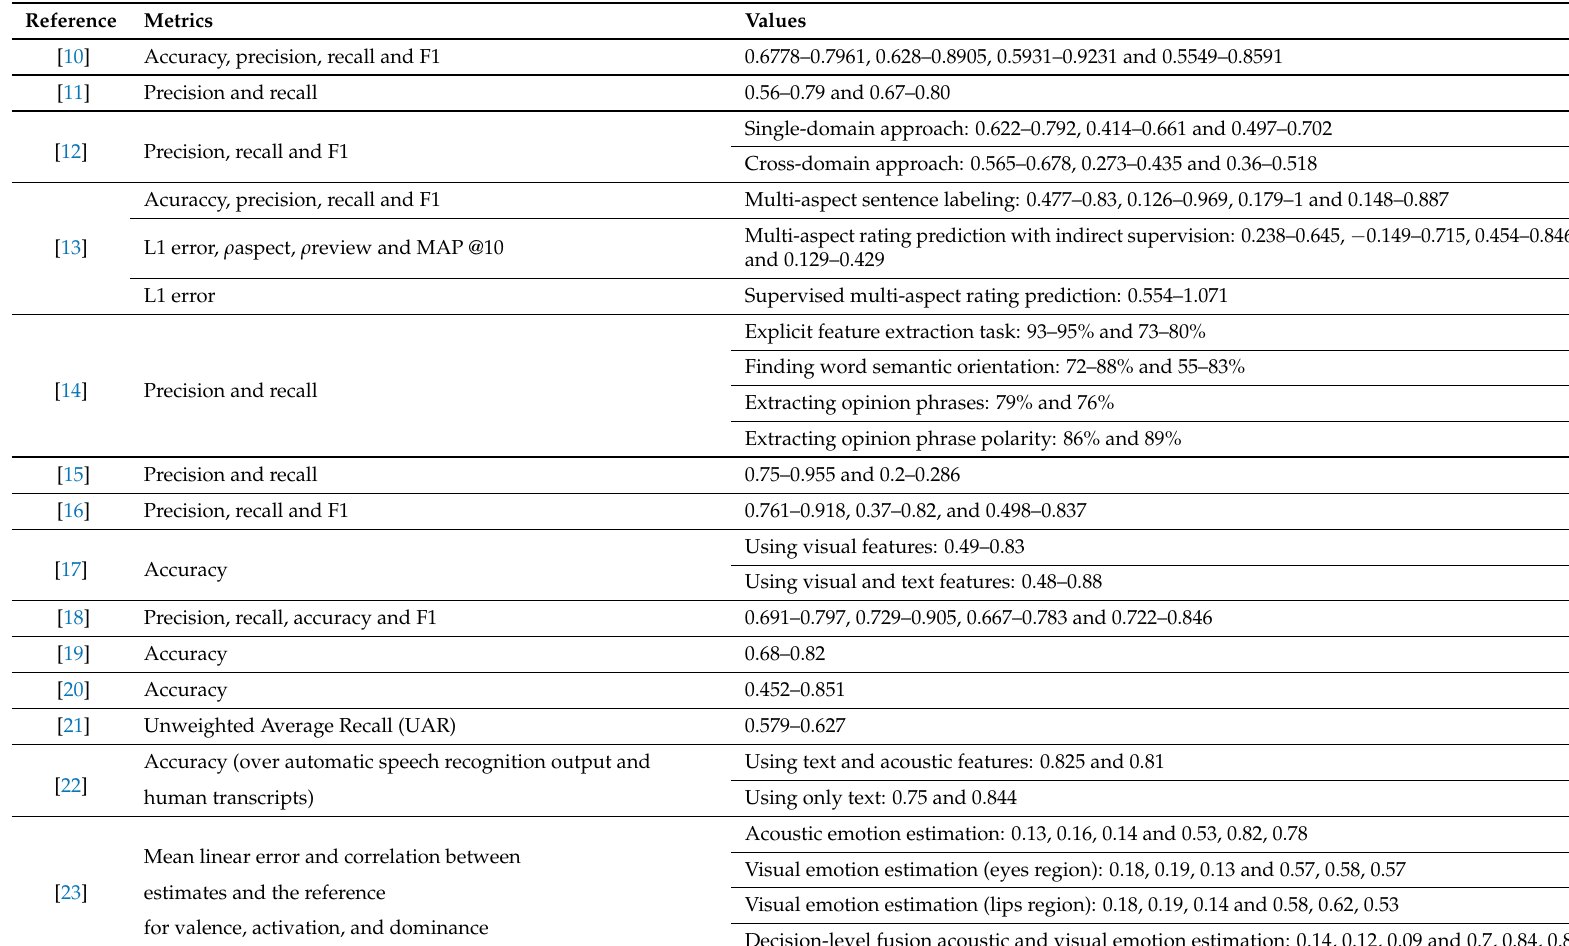
Table 1. Performance of the detection